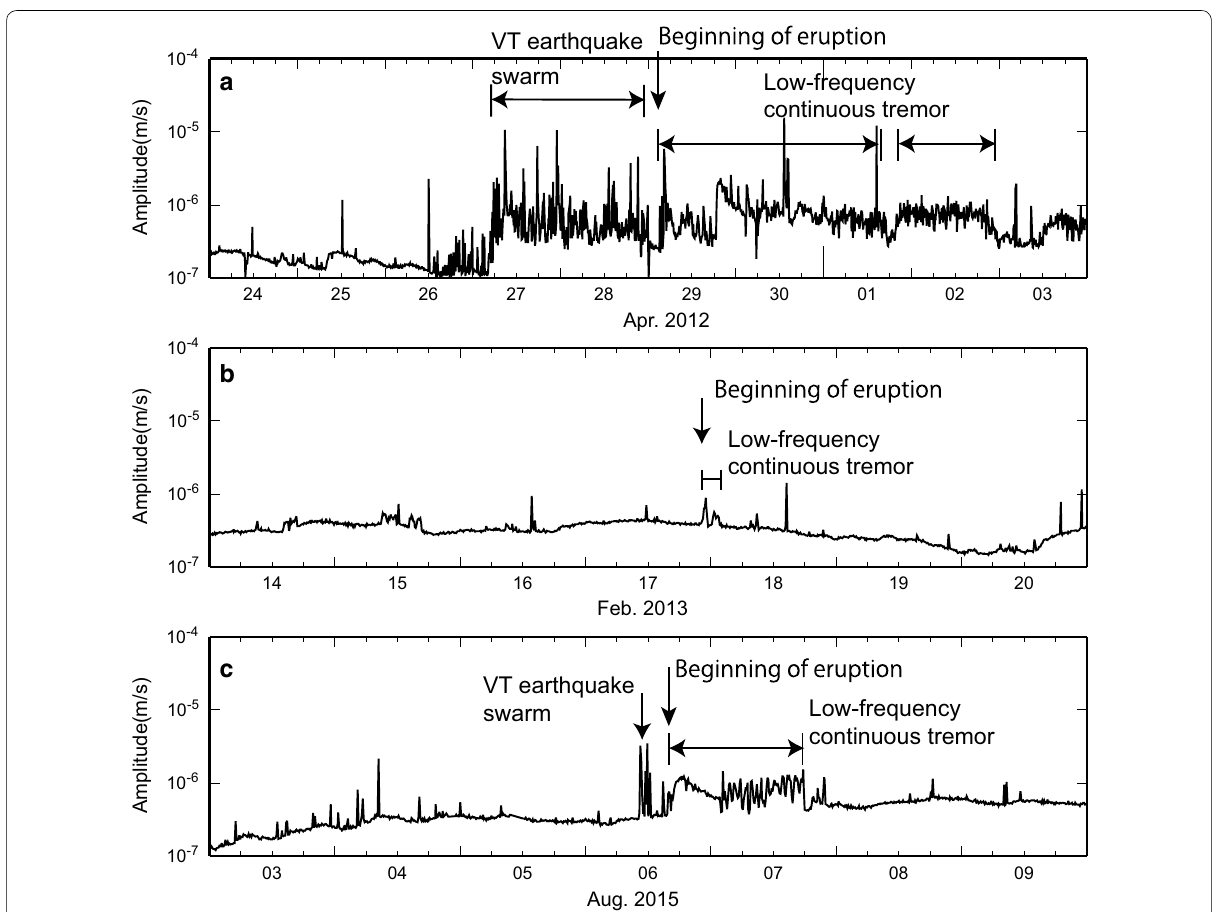
Fig. 5 The 10-min average of the root mean square amplitude of the seismometer at IJMV before and after the phreatic eruptions of a April 29, 2012; b February 17, 2013; and August 6, 2015. The seismometer data are vertical components and applied bandpass filters of 0.1–2